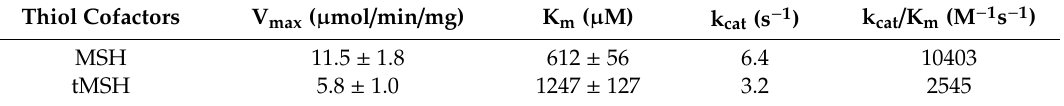
Table 1. Kinetic data for the enzyme reaction catalyzed by Ni 2 + -reconstituted PDO. Thiol